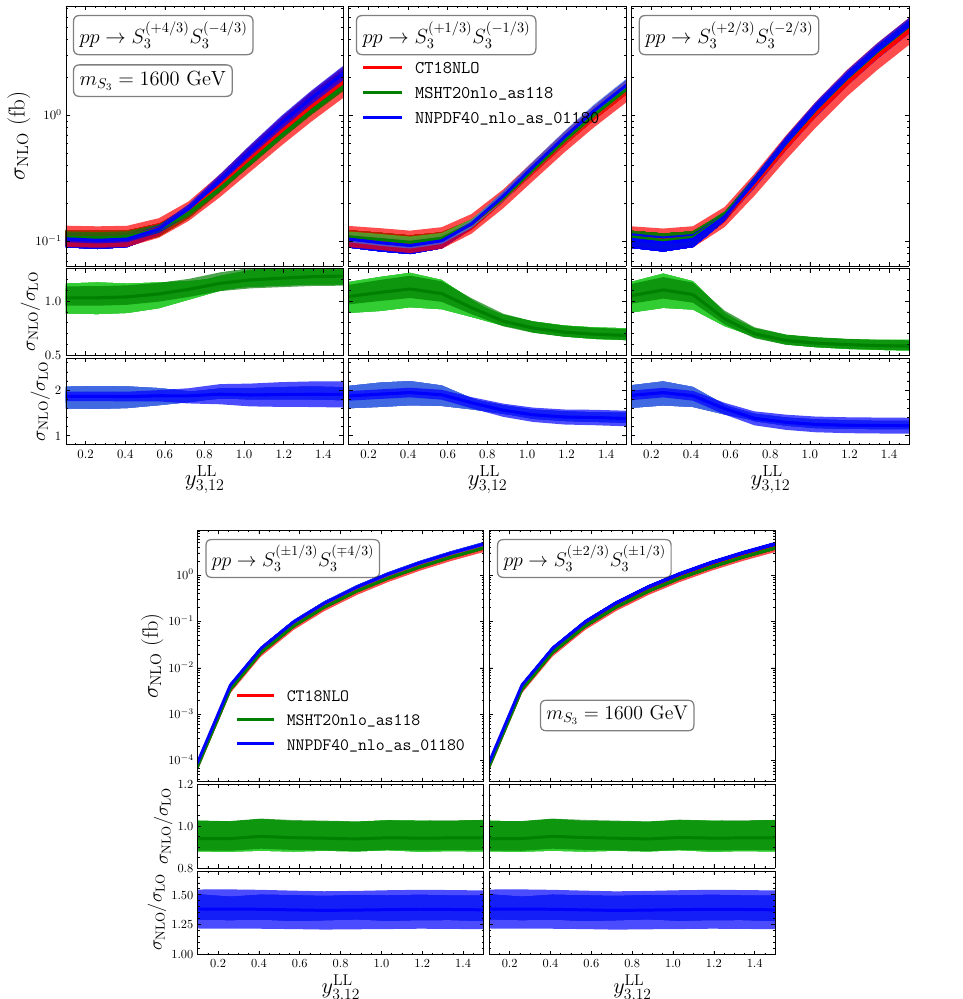
Figure 3 . Same as in figure 2 but for processes involving solely S 3 leptoquark eigenstates. In the upper panels, we shown results as a function of y = y LL for the diagonal channels, i.e. 3 , 12 pp → S (+4 / 3) S ( − 4 / 3) (left), pp → S (+1 / 3) S ( − 1 / 3) (middle) and pp → S (+2 / 3) S ( − 2 / 3) (right), whereas 3 3 3 3 3 3 in the lower panels we focus on the off-diagonal production modes pp → S ( ± 1 / 3) S ( ∓ 4 / 3) (left) and 3 3 pp → S ( ± 2 / 3)